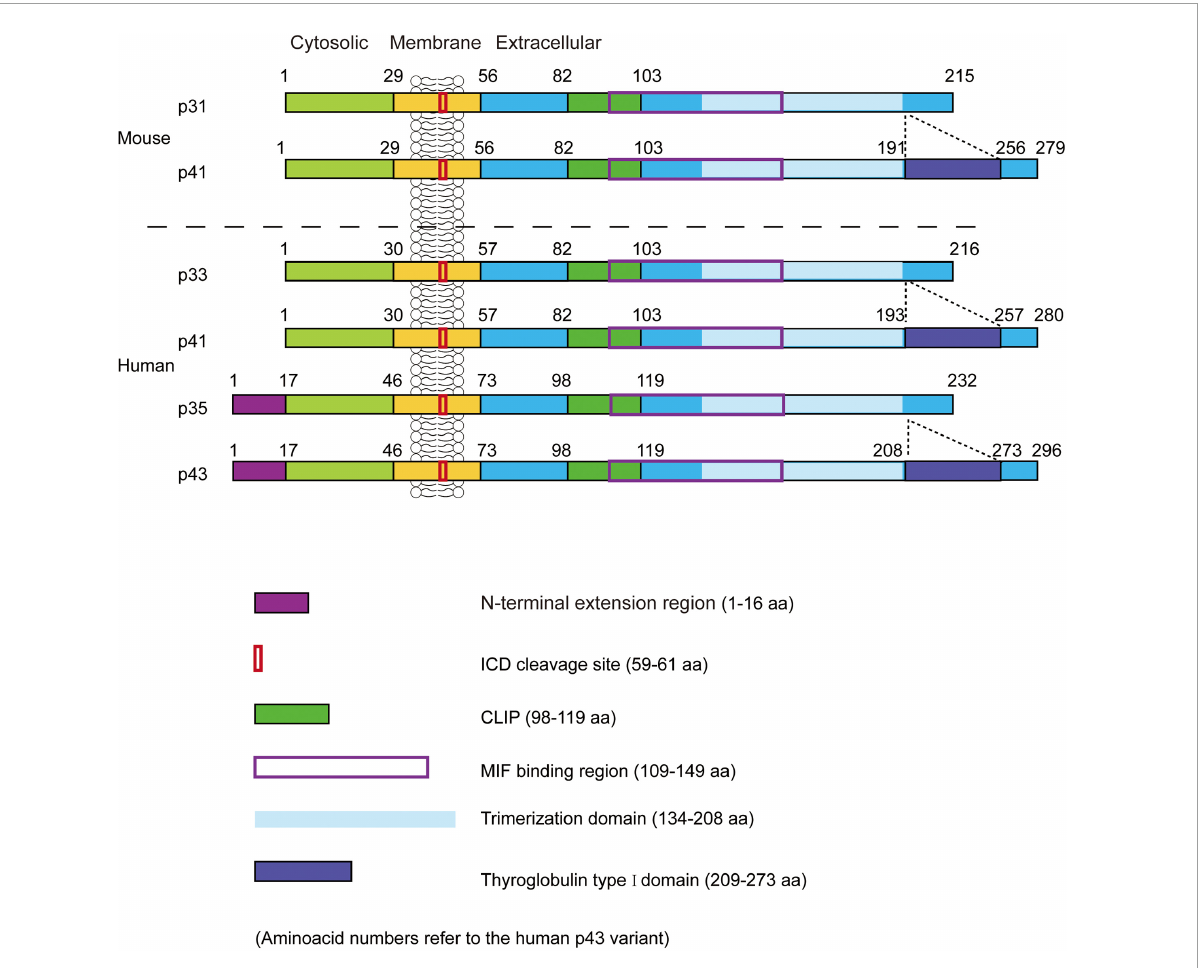
FIGURE2 The structure of mouse and human leukocyte differentiation antigen 74 (CD74). Two isoforms (p31 and p41) in mice and four isoforms (p33, p35, p41, and p43) in humans. CLIP, the class II-associated invariant chain peptides; ICD, intracellular domains. Figure adopted from Schroder et al. with permission (No. 5390740929053)